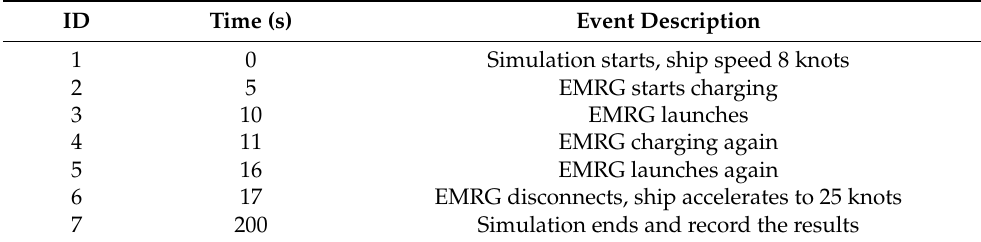
Figure 10. EMRG operation power profile. Table 4. Discrete event sequences during pulse load launch.